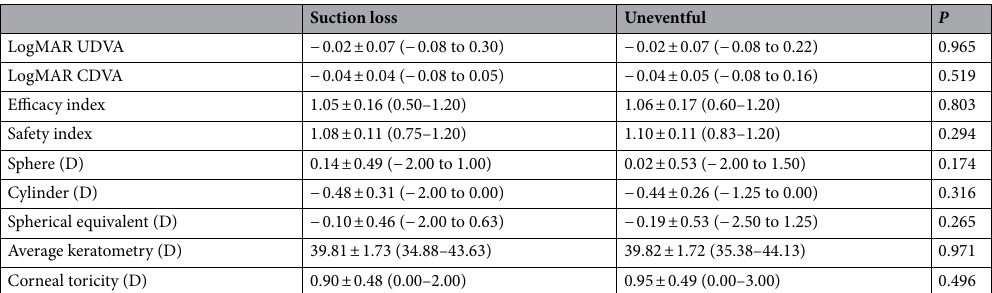
Suction loss Uneventful P LogMAR